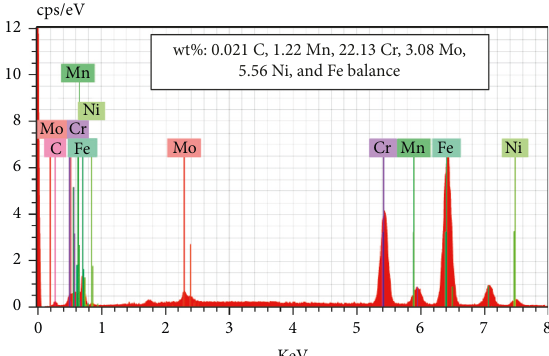
Figure 1: Chemical composition of 2205 cold rolled plate.